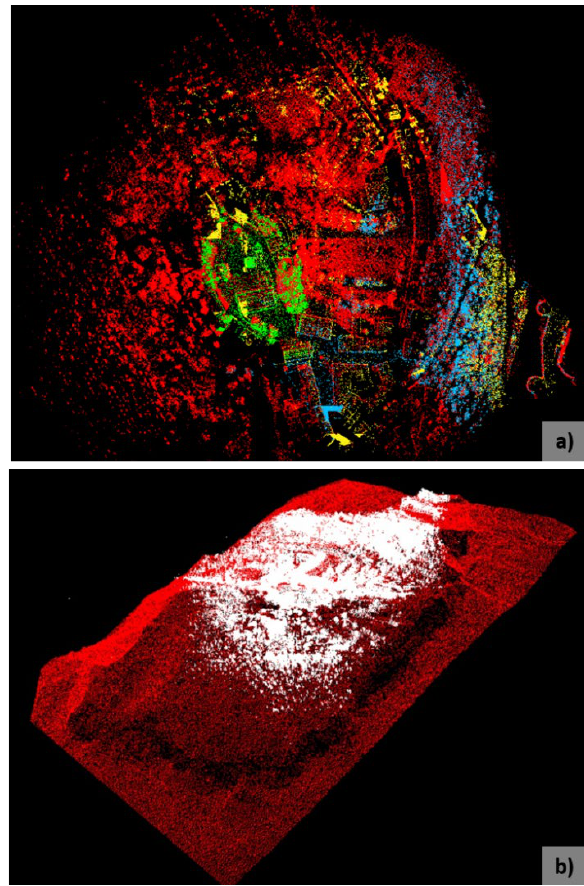
Figure 9. TLS surveys of the urban centre: a) the acquired point clouds; b) the point cloud of the whole slab (in red) and the clouds acquired by TLS on the top (white).